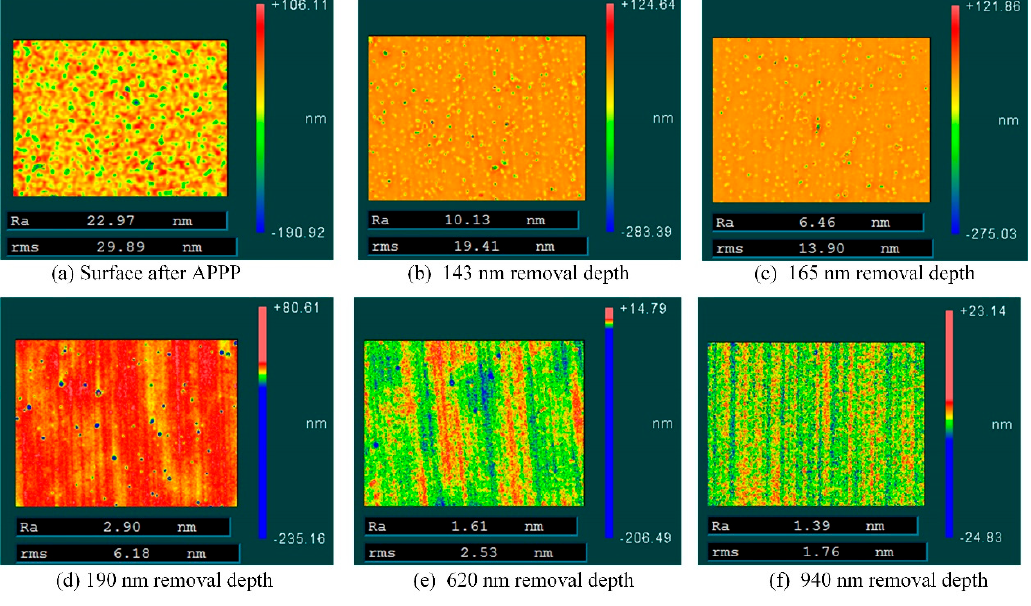
Figure 7. Surface texture of substrate F under different removal depth of BP. ( a ) Surface after APPP; ( b ) 143 nm; ( c ) 165 nm; ( d ) 190 nm; ( e ) 620 nm and ( f ) 940 nm.